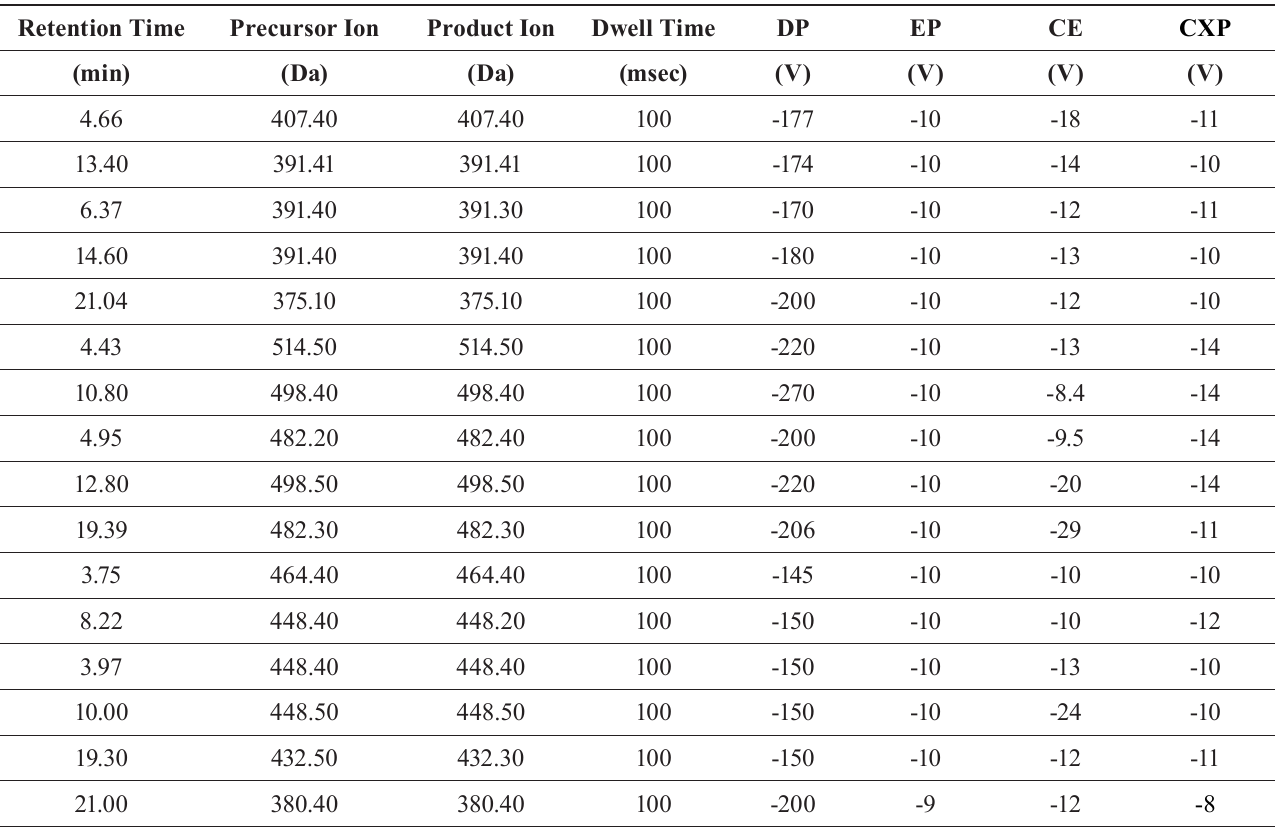
Supplementary Table SI - Summary of bile acids and Mass Spectrometry